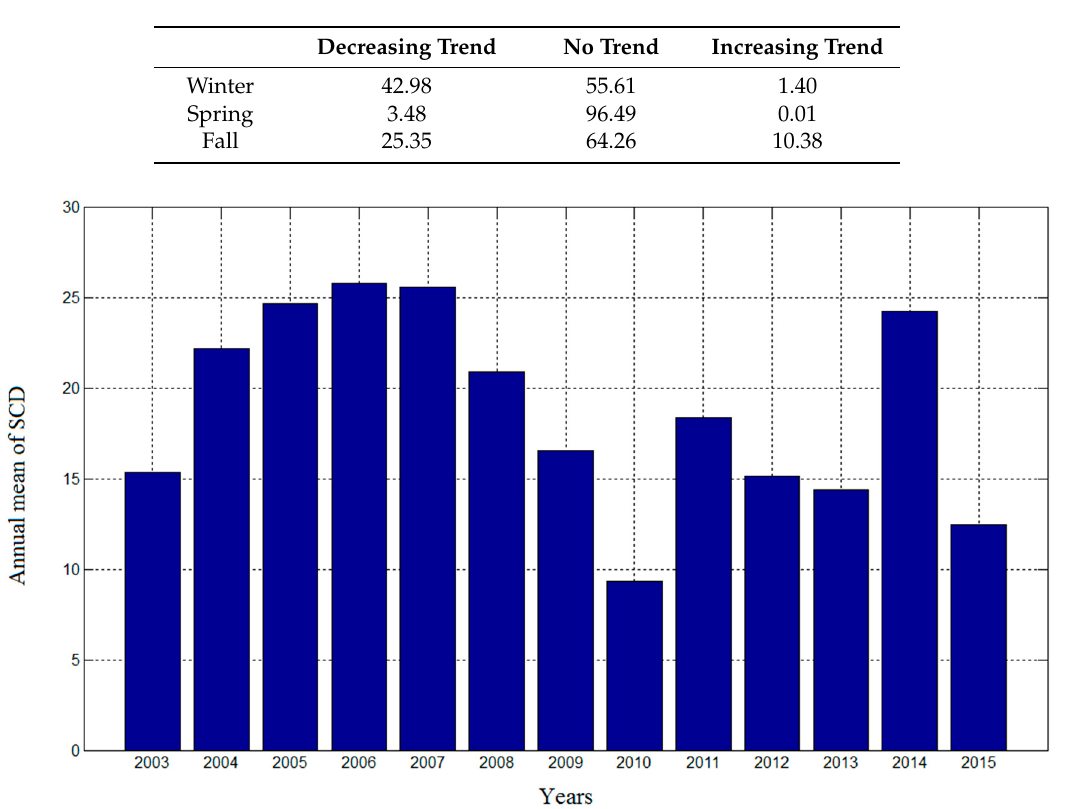
Table 1. Percentage of the Basin area with positive, negative, and nonexistent trends in SCD at the 0.05 level of confidence.